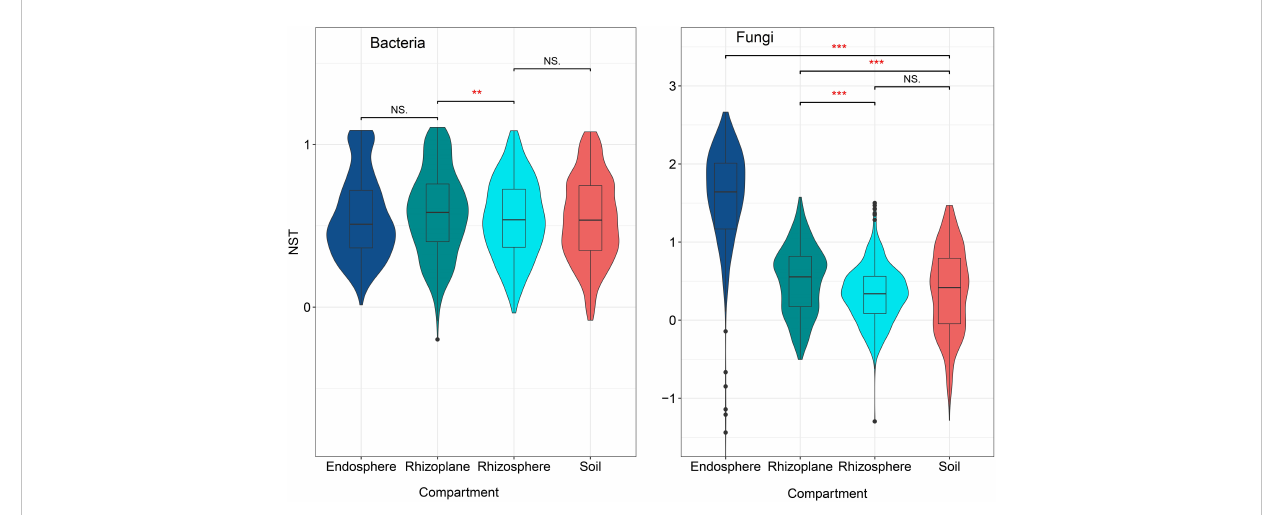
FIGURE 7 The normalized stochasticity ratio (NST) for bacterial and fungal communities in different compartments of the rubber tree root. NST < 50%: community assembly is more deterministic; NST > 50%: community assembly is more stochastic. ** p < 0.01, *** p < 0.001, NS, not signi fi